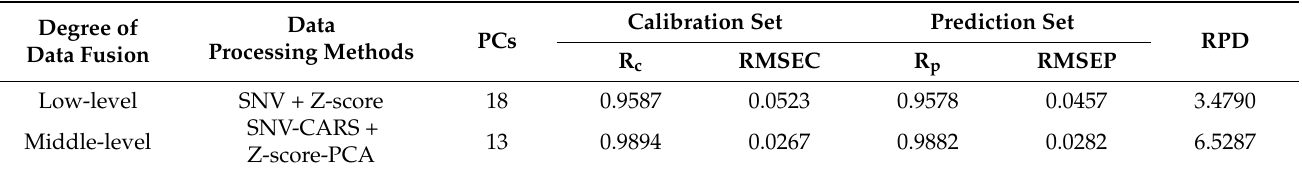
Table 5. Performance of the PLS model based on data fusion for moisture prediction in Longjing tea